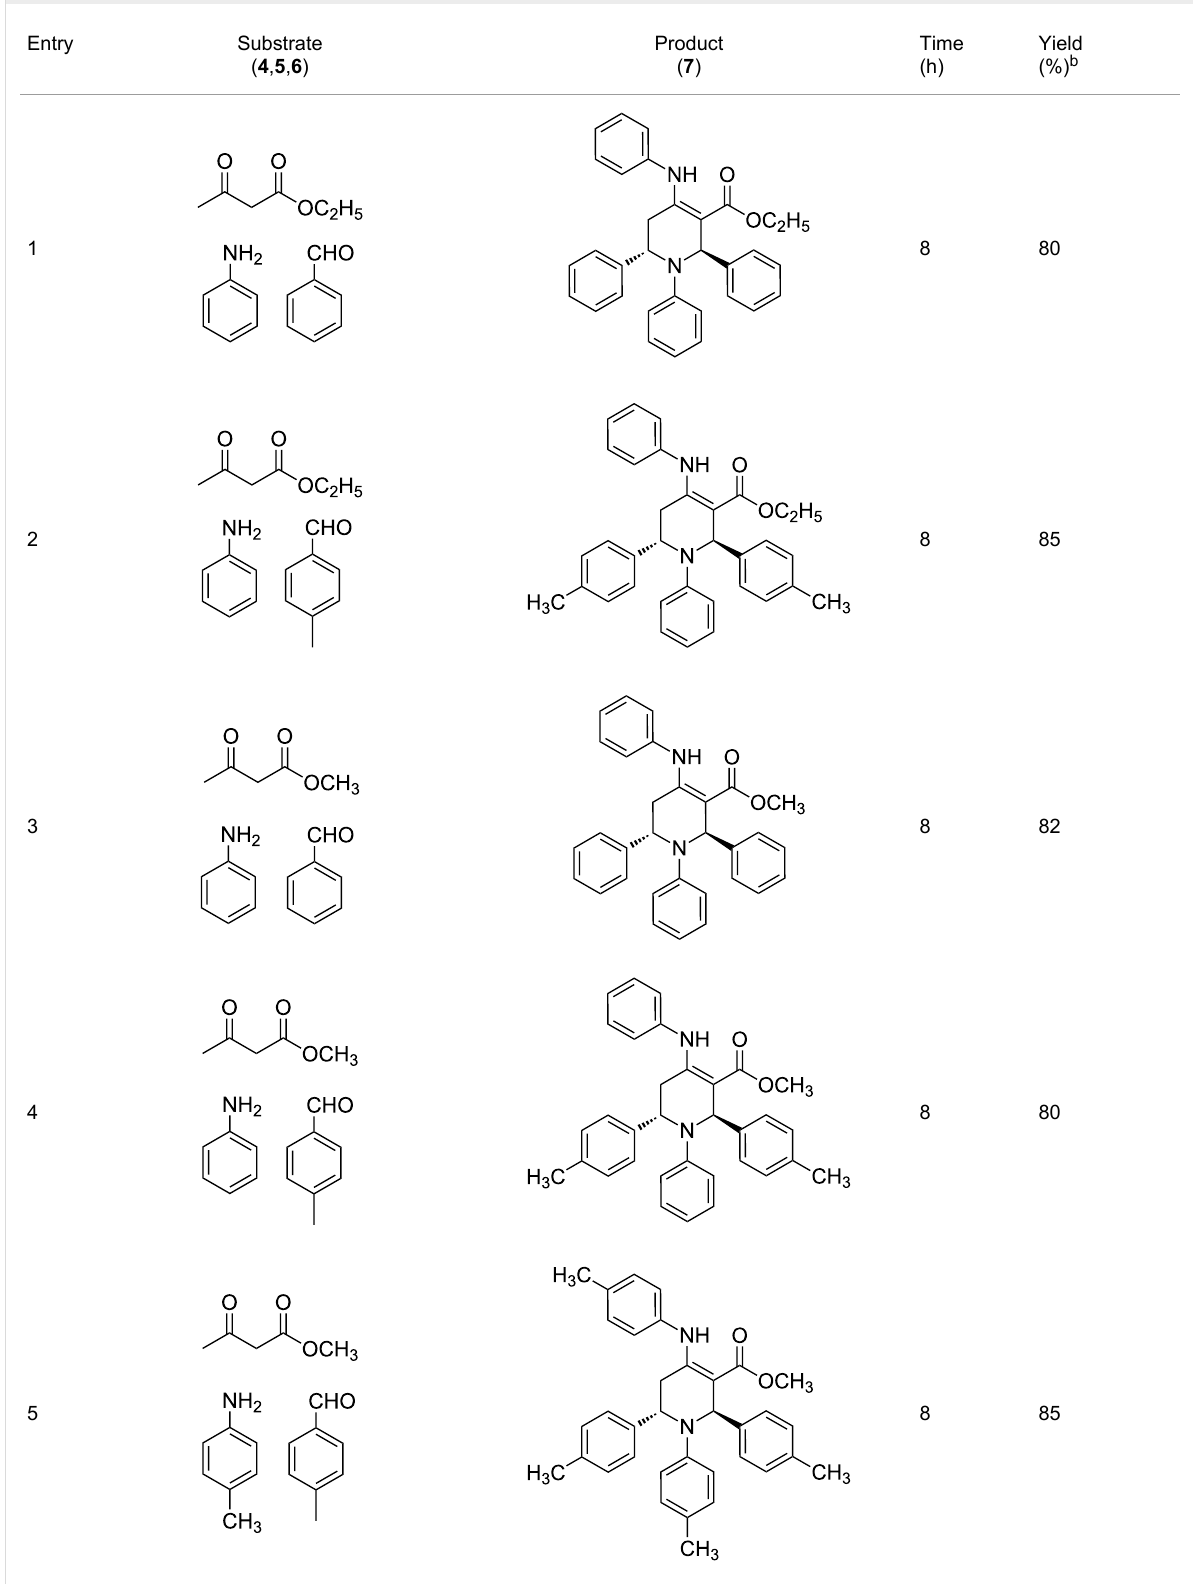
Table 1: Synthesis of functionalized piperidines with [K + PEG]Br 3 − in ethanol.